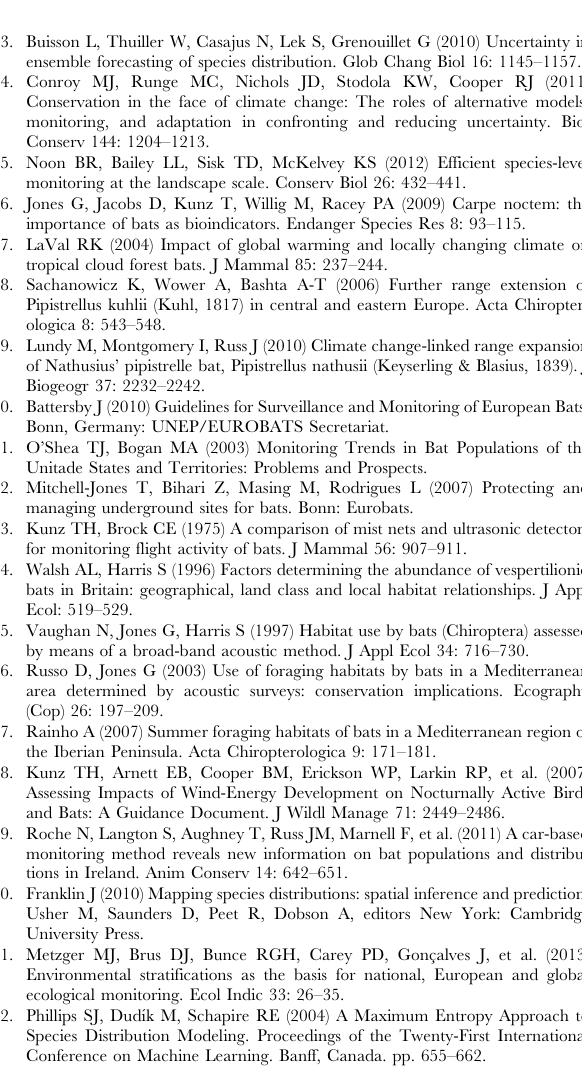
Figure S8 Response curves for the EGVs most related to the predicted distribution of Nyctalus leisleri . Figure S9 Response curves for the EGVs most related to the predicted distribution of Barbastella barbastellus . Figure S10 Response curves for the EGVs most related to the predicted distribution Tadarida teniotis . Figure S11 Areas where each target species is likely to gain, lose or maintain suitable climatic space under scenario A2a. Figure S12 Areas where each target species is likely to gain, lose or maintain suitable climatic space under scenario B2a. Figure S13 Proportion of area occupied by suitability class for each species.